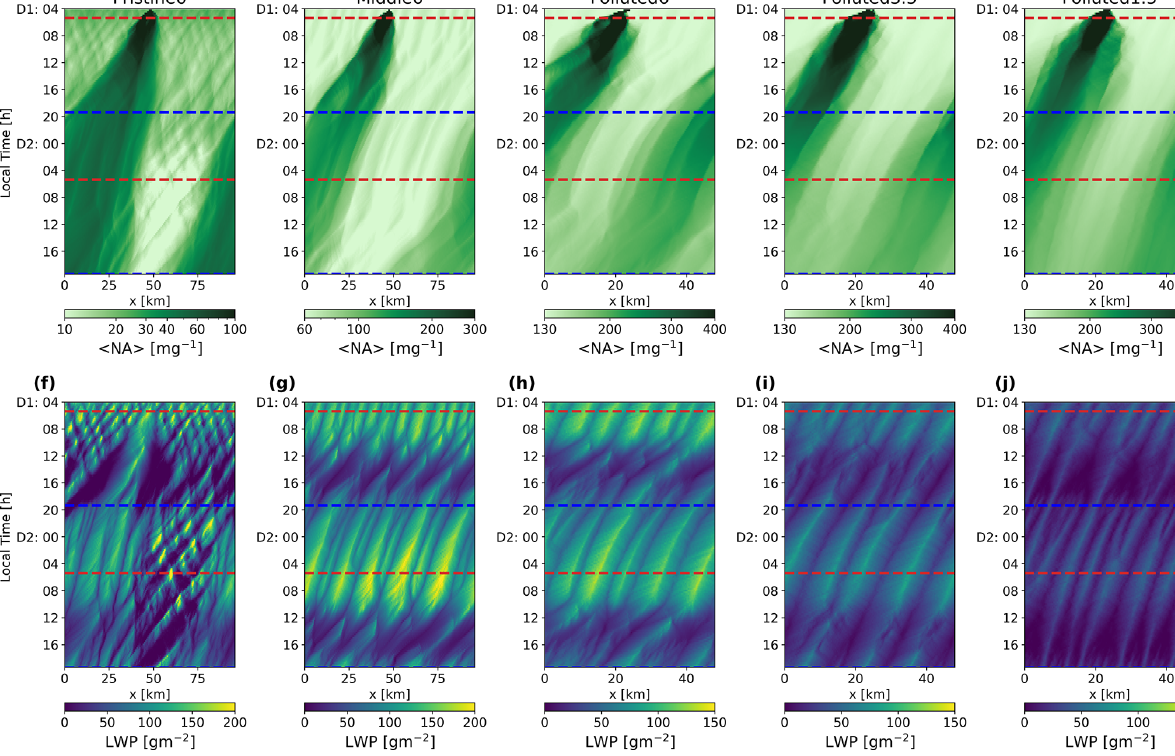
Figure 5. Hovmöller plots of (a–e) (cid:104) N a (cid:105) and (f–j) the LWP in the Plume runs for the (a, f) Pristine6, (b, g) Middle6, (c, h) Polluted6, (d, i) Polluted3.5, and (e, j) Polluted1.5 cases across the 2d simulation. Red and blue dashed lines indicate the times of sunrise and sunset,